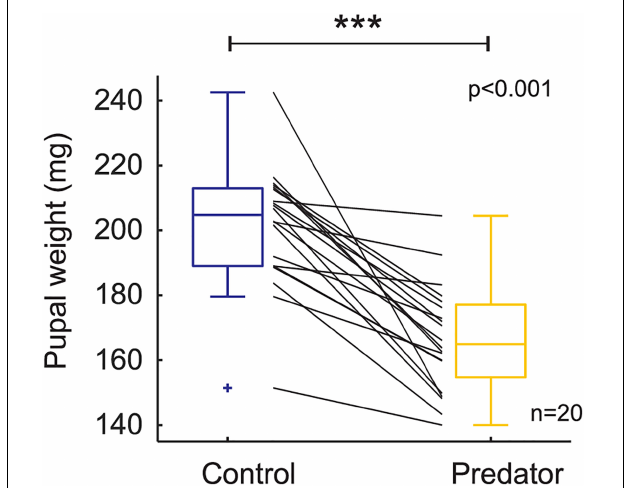
FIGURE 6 | Pupal weight based on raw data (i.e., each black and gray line represents a family). Boxplots show the mean values on control and predator treatment. *** means high significance; + means